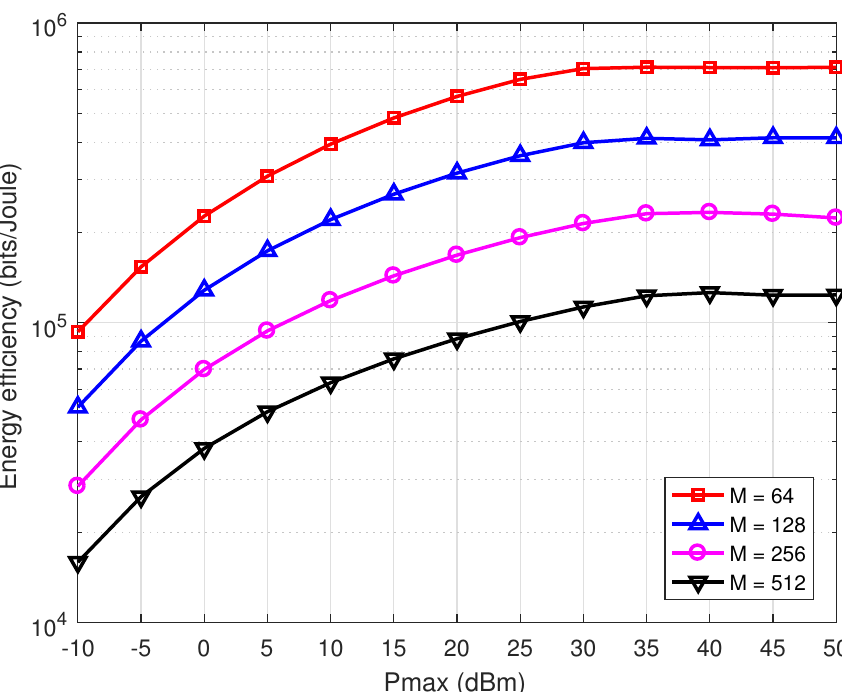
Figure 3. EE performance of the proposed EE maximization approach versus the multicast power budget P max for different numbers of BS antennas M